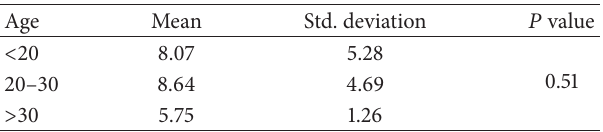
Table 3: Comparison of mean score of DLQI in patients with acne vulgaris regard to age using